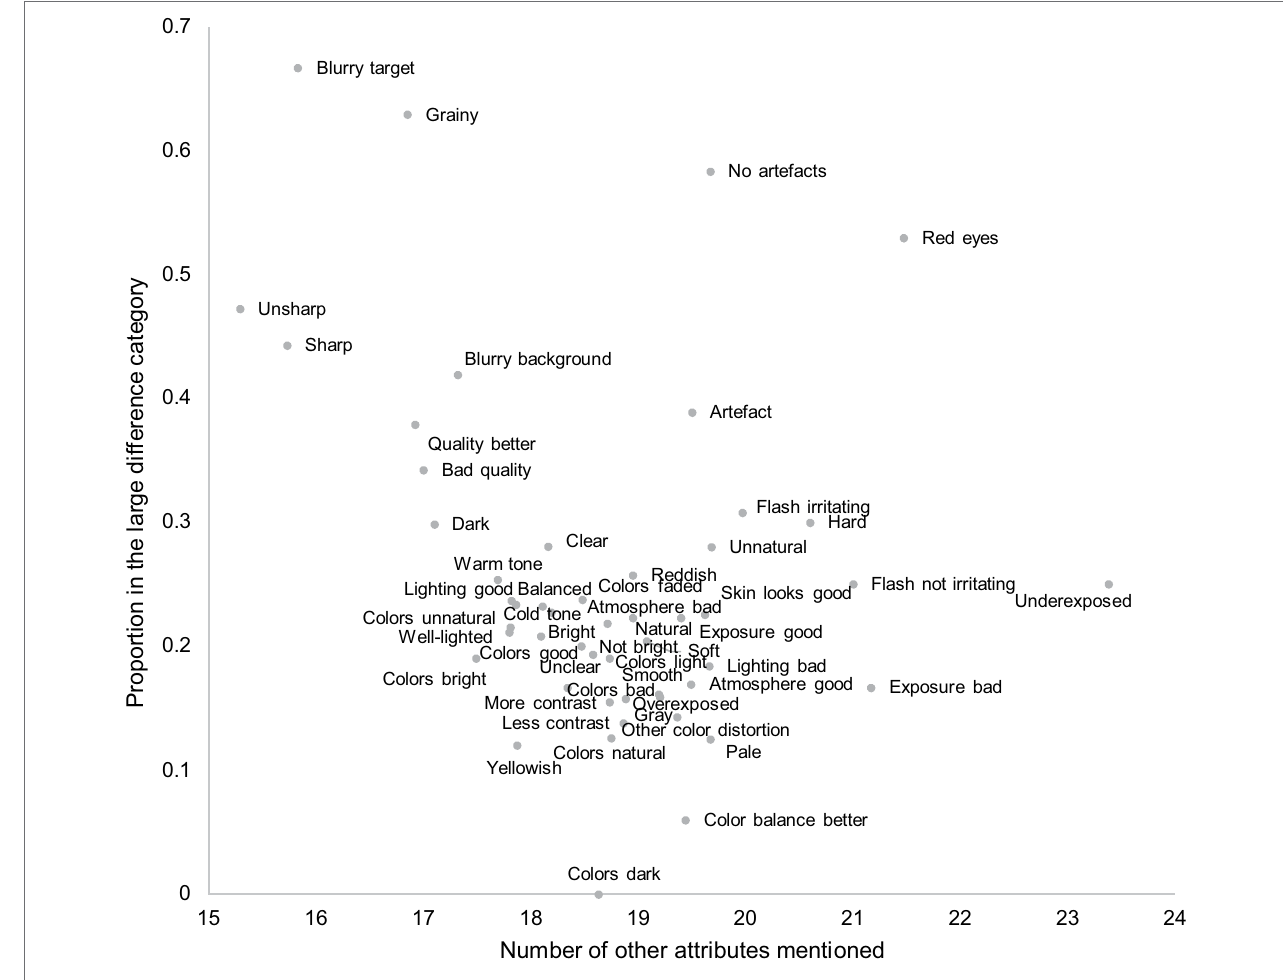
FIGURE 5 | Proportion of attributes in the large difference category and number of other attributes mentioned in the pair. The subjective attributes most often mentioned for large quality differences were less often accompanied by other attributes. However, when quality differences were small, there was a plethora of different subjective attributes, most referring to color balance and general lightness level. In other words, choices in large quality difference pairs is usually explained by smaller number of subjective attributes than in small quality difference